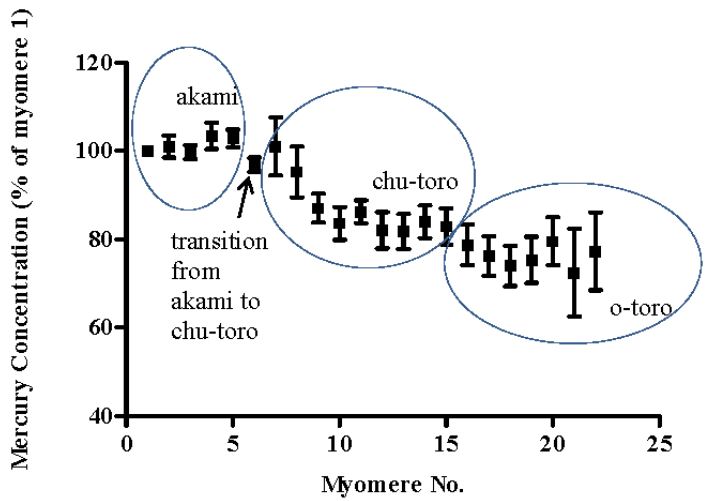
Figure 3. Systemic variation in the mean mercury concentration of muscle myomeres in the ventral region of SBT steaks. Mercury concentration is presented as a percentage of myomere 1 mercury